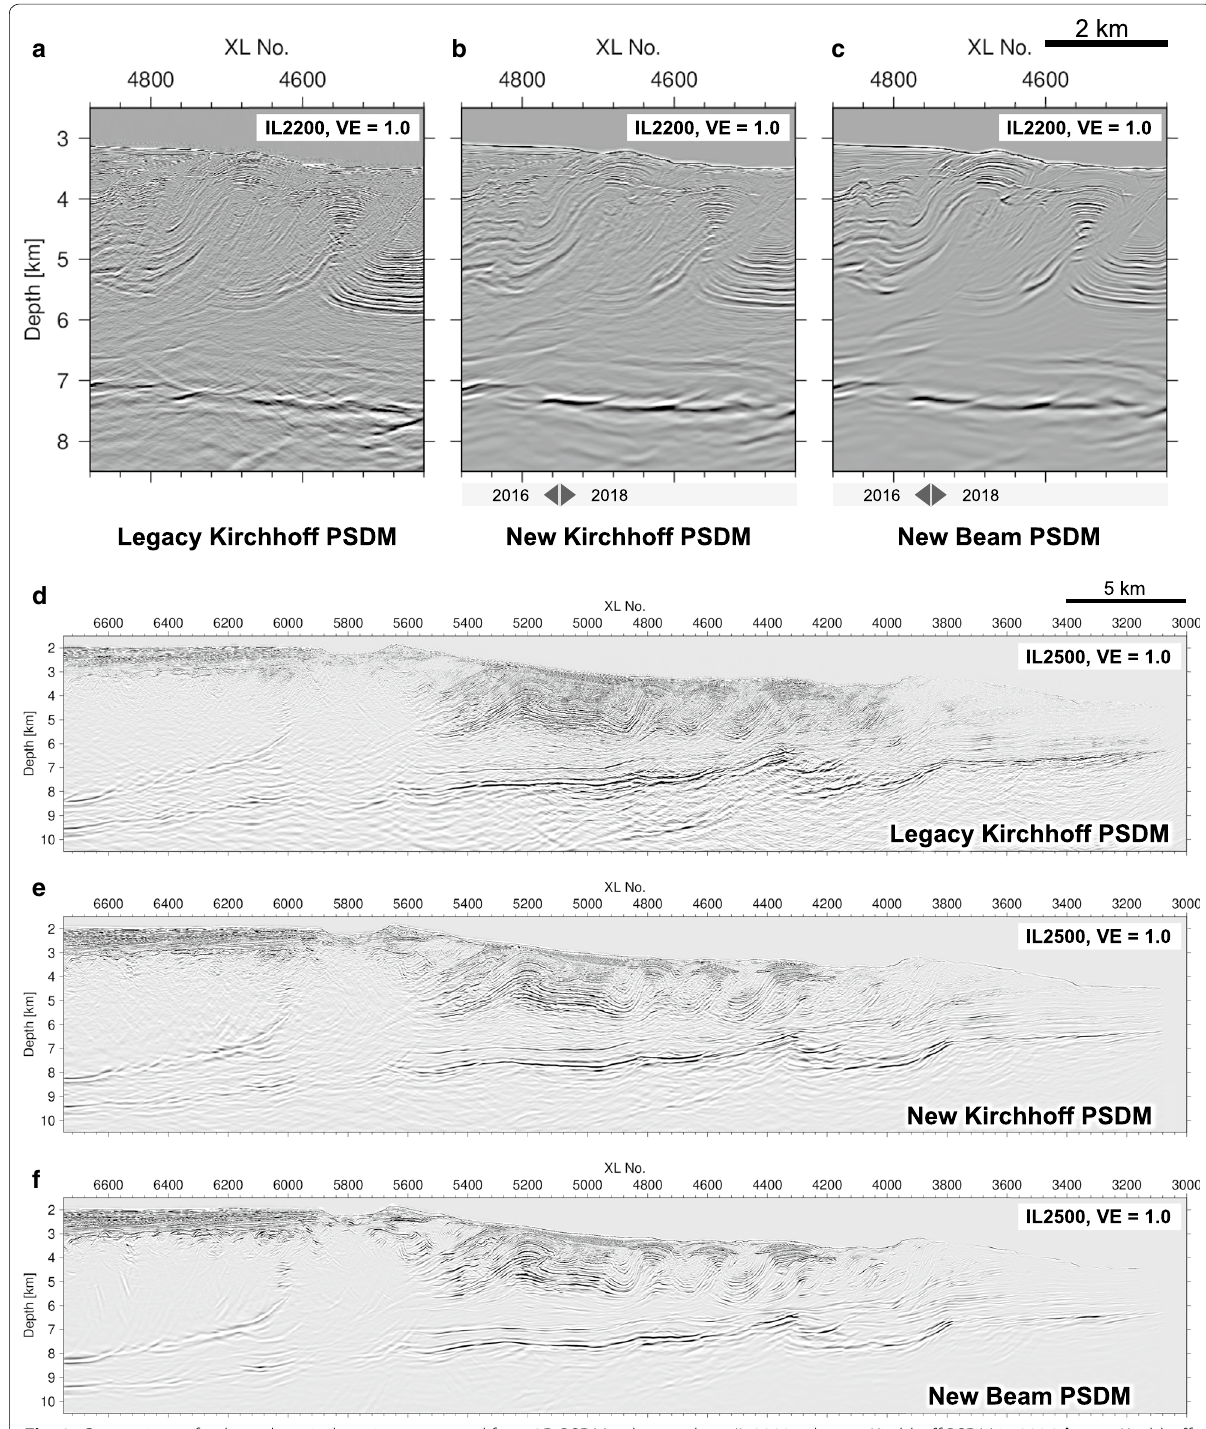
Fig. 2 Comparison of enlarged vertical sections extracted from 3D PSDM volumes along IL 2200: a legacy Kirchhoff PSDM in 2006, b new Kirchhoff PSDM in 2016–2018 and c new beam PSDM in 2016–2018. Comparison of vertical sections of the whole reprocessed range along IL 2500: d